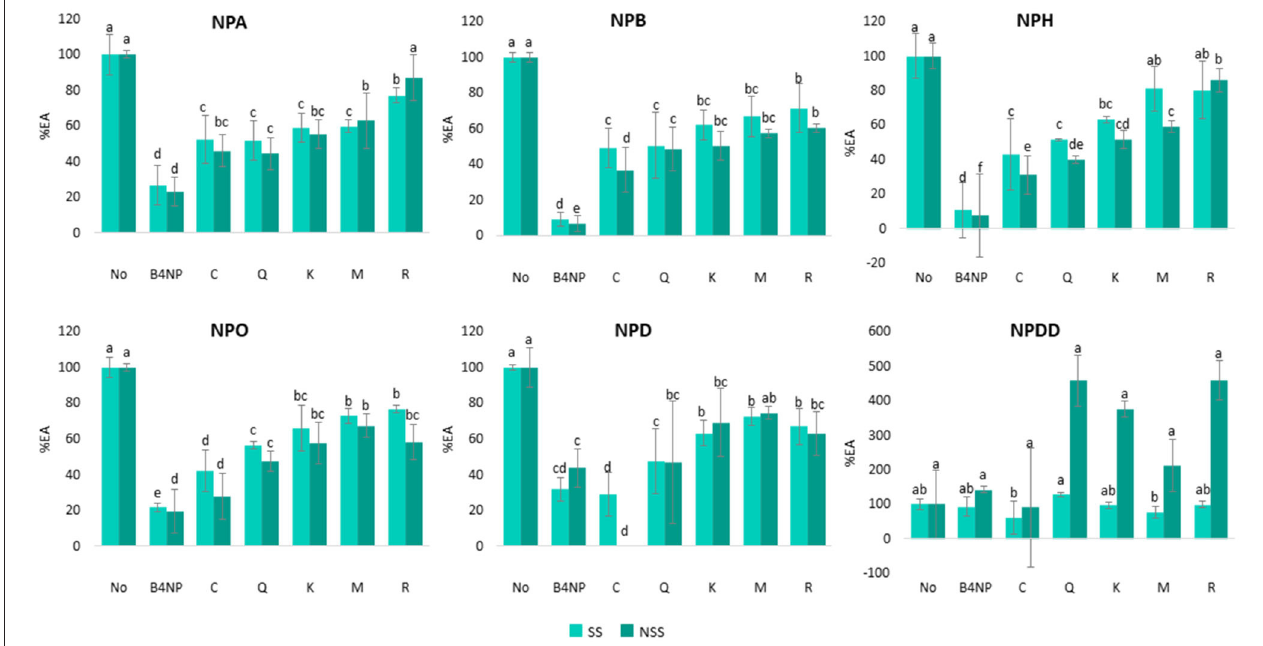
FIGURE 3 | Percentage of EA (%EA) in SS and NSS toward six p-NP-esters with different carbon chain length (from C2 to C12) in the presence of five single wine polyphenols: catechin (C), quercetin (Q), kaempferol (K), mirycetin (M), and resveratrol (R) assayed at the maximum concentration found in the wines. B4NP 0.1Mm was employed as a positive control. Different letters above the bars mean significant differences ( p < 0.05) from Tukey’s